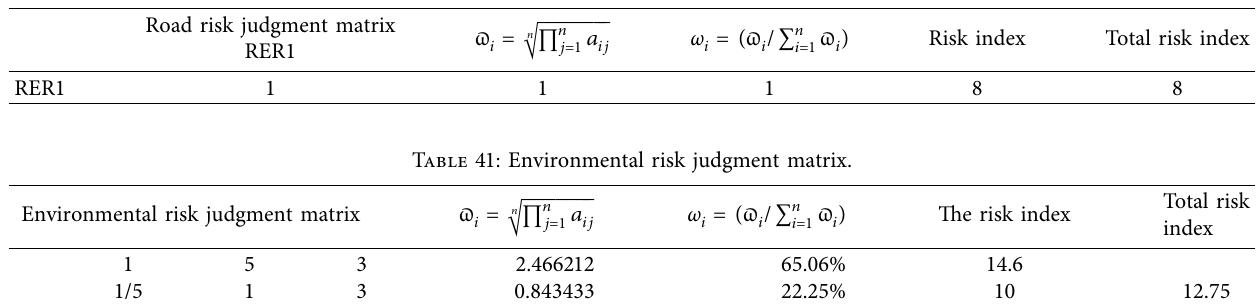
Table 40: Environmental risk judgment matrix.